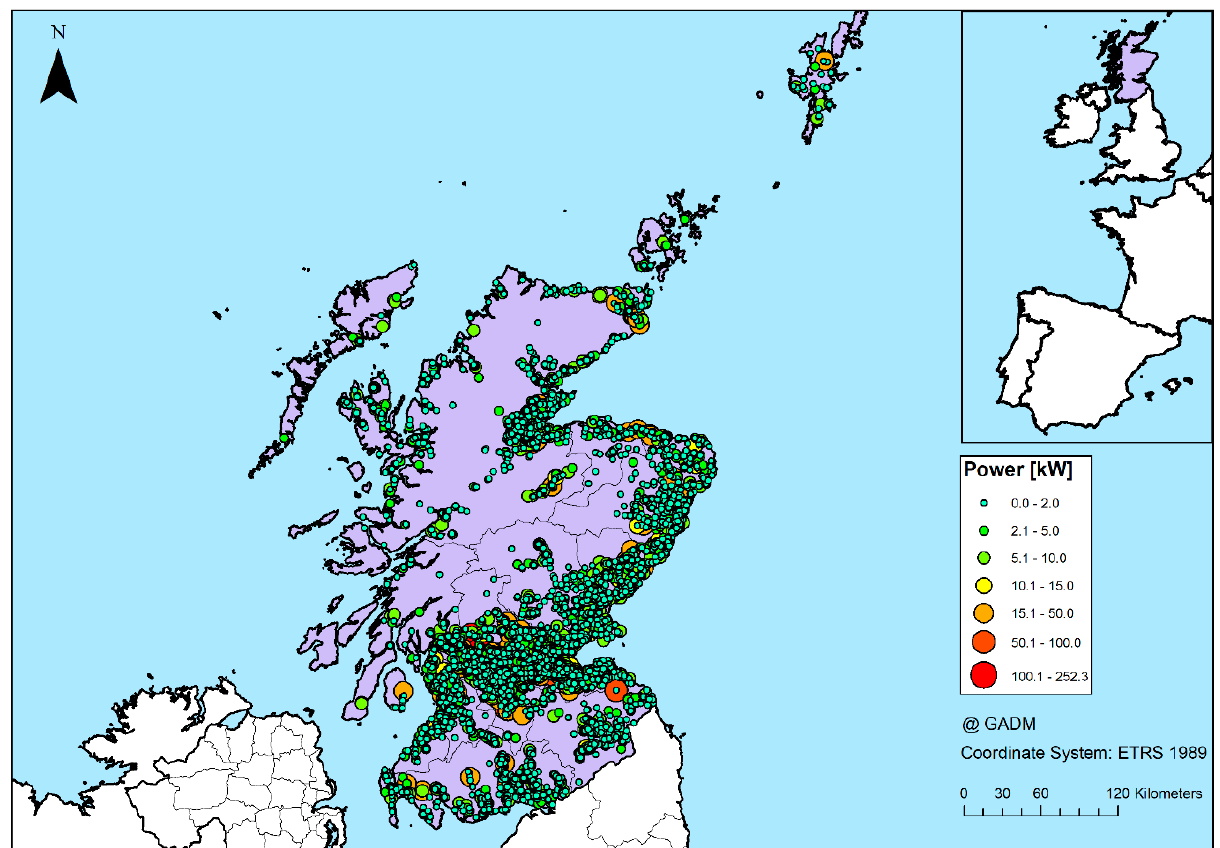
Figure 3. Power potential for MHP in the different sites identified in Scotland, for the drinking water sector.